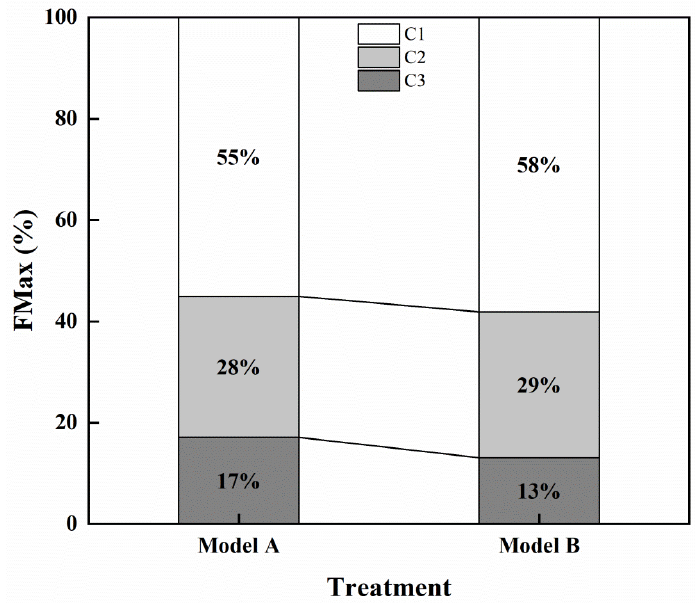
Figure 8. The percentage of PARAFAC-derived components in three surface soil DOM from temperate forest. Model A, the control group; Model B, the group with N addition. C1, fulvic-like constituent; C2, humic-like constituents; C3, protein-like constituent.